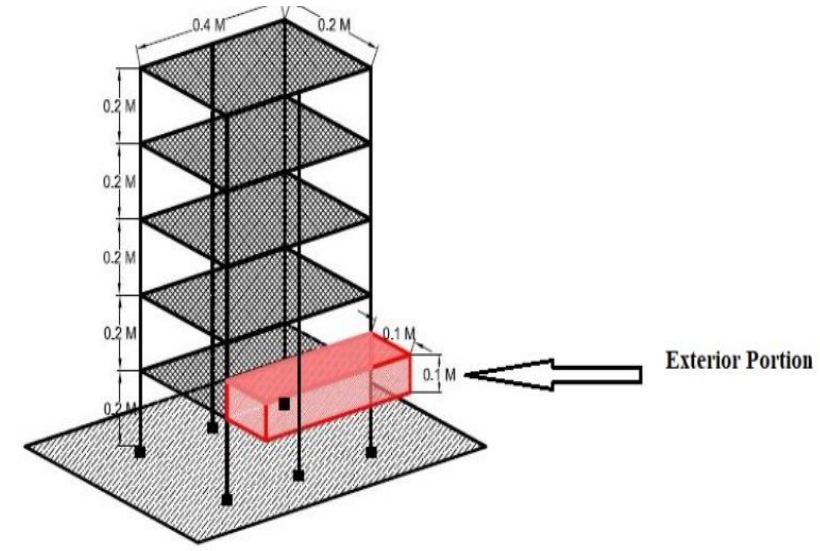
Fig. 1. Testing arrangements for First load